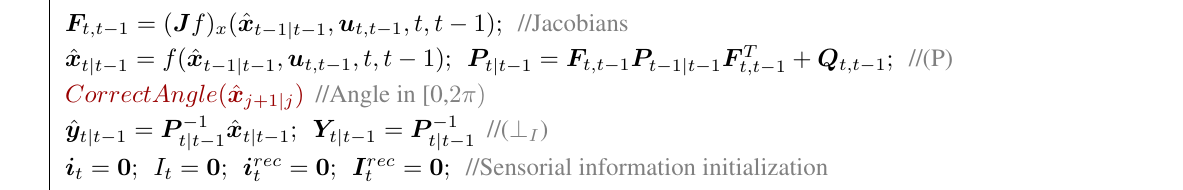
Figure 4. Prediction and Measurement Update Steps of the adapted EIFAsyn. ( a ) Prediction step from t − 1 to t ; ( b ) Update step for ξ arriving at t